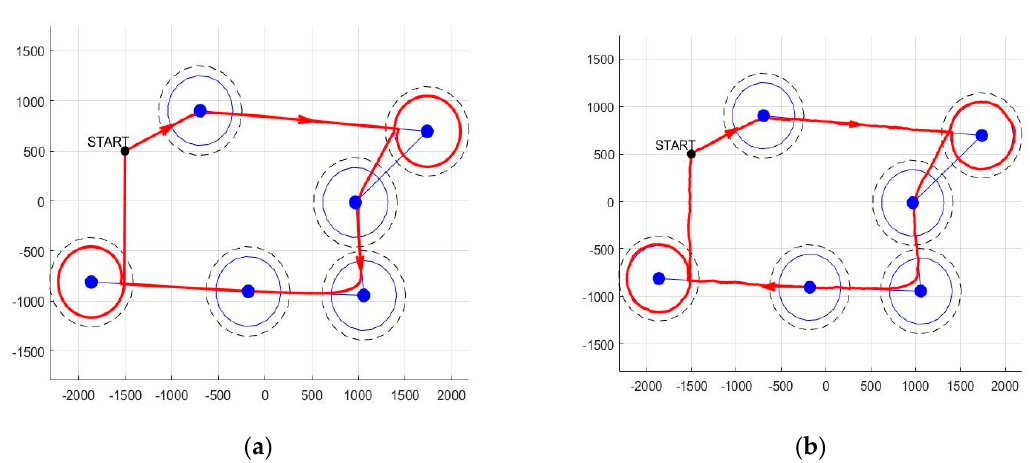
Figure 10. Illustration of combined (segment and loitering circle) tracking. In all cases, the loitering circle radius was taken to be 150 m: ( a ) nominal case and ( b ) with wind disturbances.